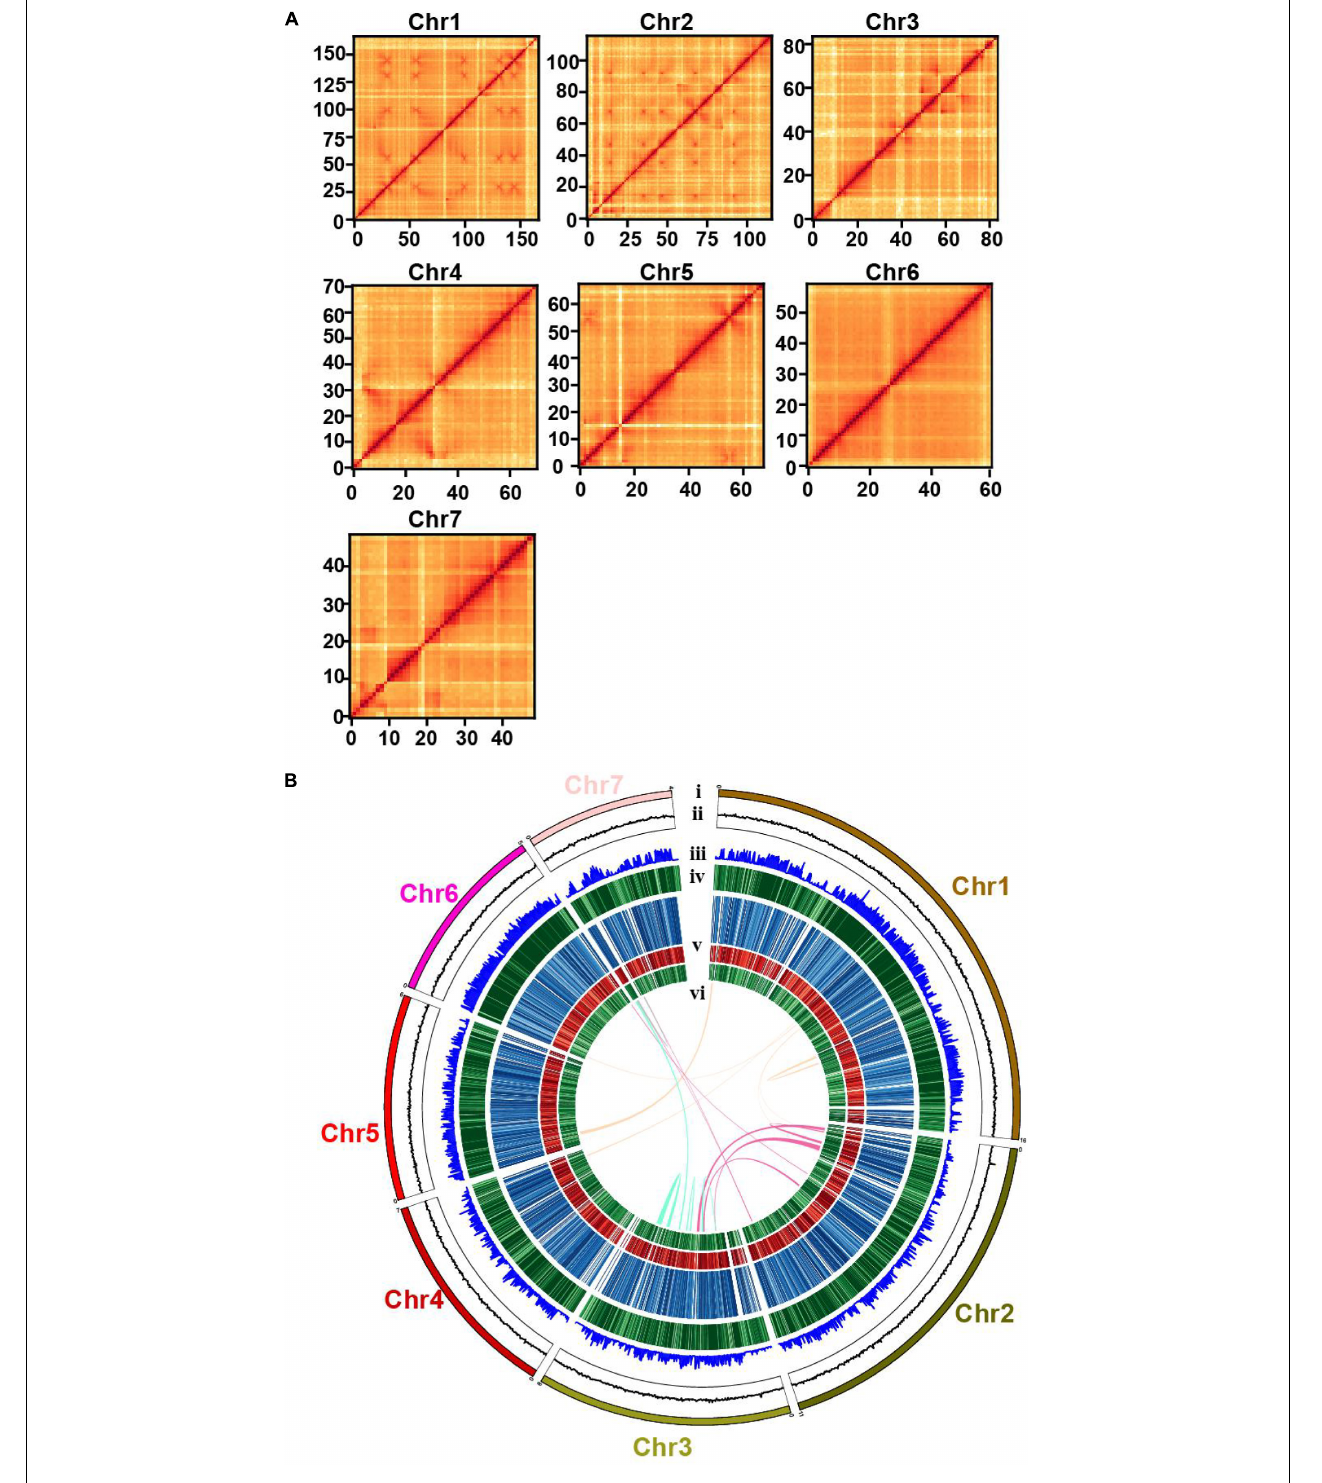
FIGURE 2 | The genome map and chromosomal features of Wolfiporia cocos genome. (A) A Hi-C map shows genome-wide all-by-all interactions between chromosomes. (B) (i), seven chromosomes of the genome of a cultivated W. cocos strain (WCLT); (ii), GC content; (iii), gene density; (iv), transposable element (TE) content; (v), gene expression levels in the mycelia, inner part of the sclerotium, and epidermis of the sclerotium from outside to inside. The color deepens as the expression level increases; and (vi), syntenic links.